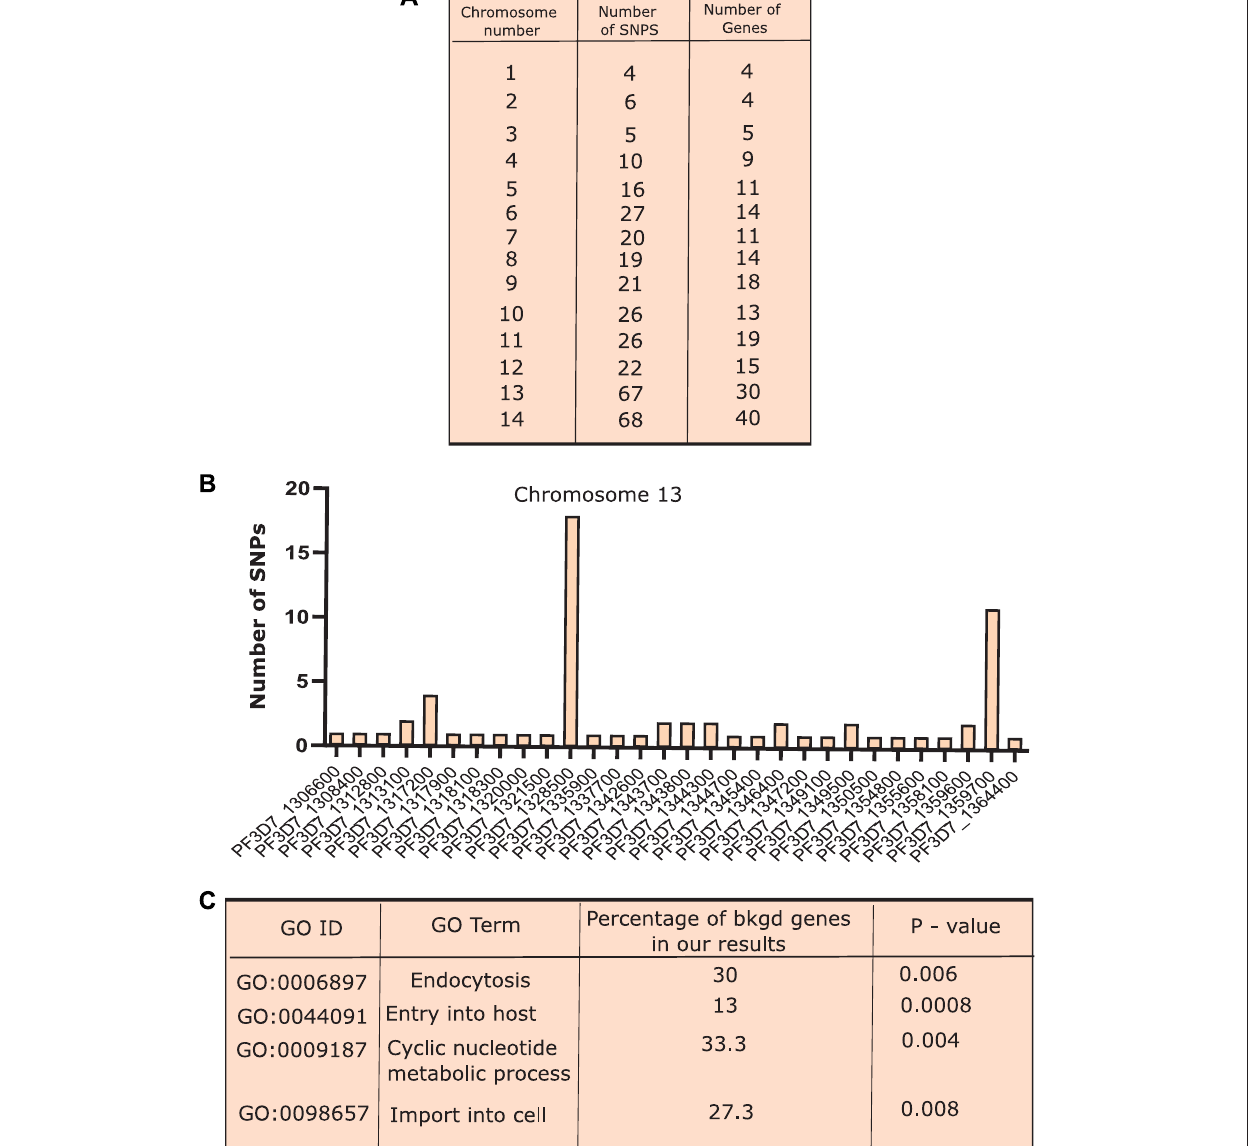
Frontiers in Genetics |